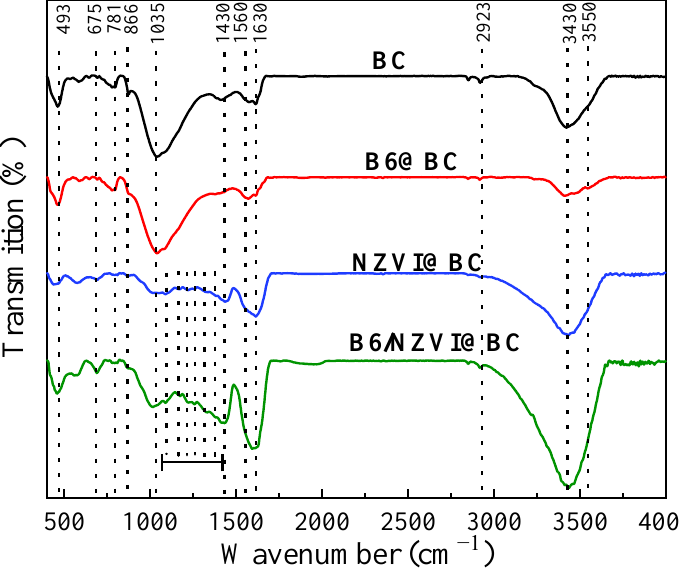
Figure 3. FTIR spectra of biochar materials: BC, B6@BC, nZVI@BC, and nZVI/B6@BC.